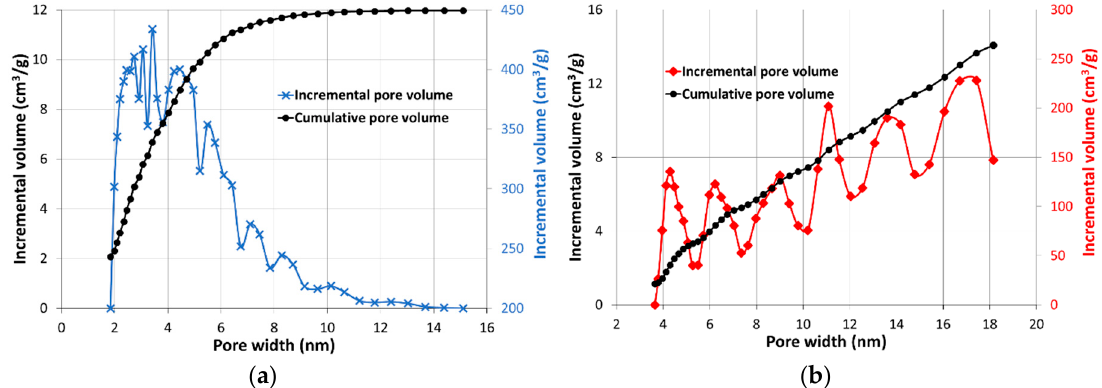
Figure 3. Incremental and cumulative pore volume as a function of pore width using the non-localized density functional theory (NLDFT) model of ( a ) SG and ( b ) CNTs.